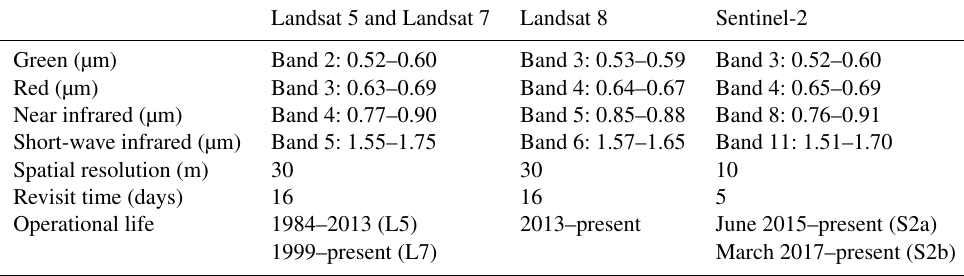
Table 1. Landsat and Sentinel image characteristics (Barsi et al., 2014; ESA, 2022).